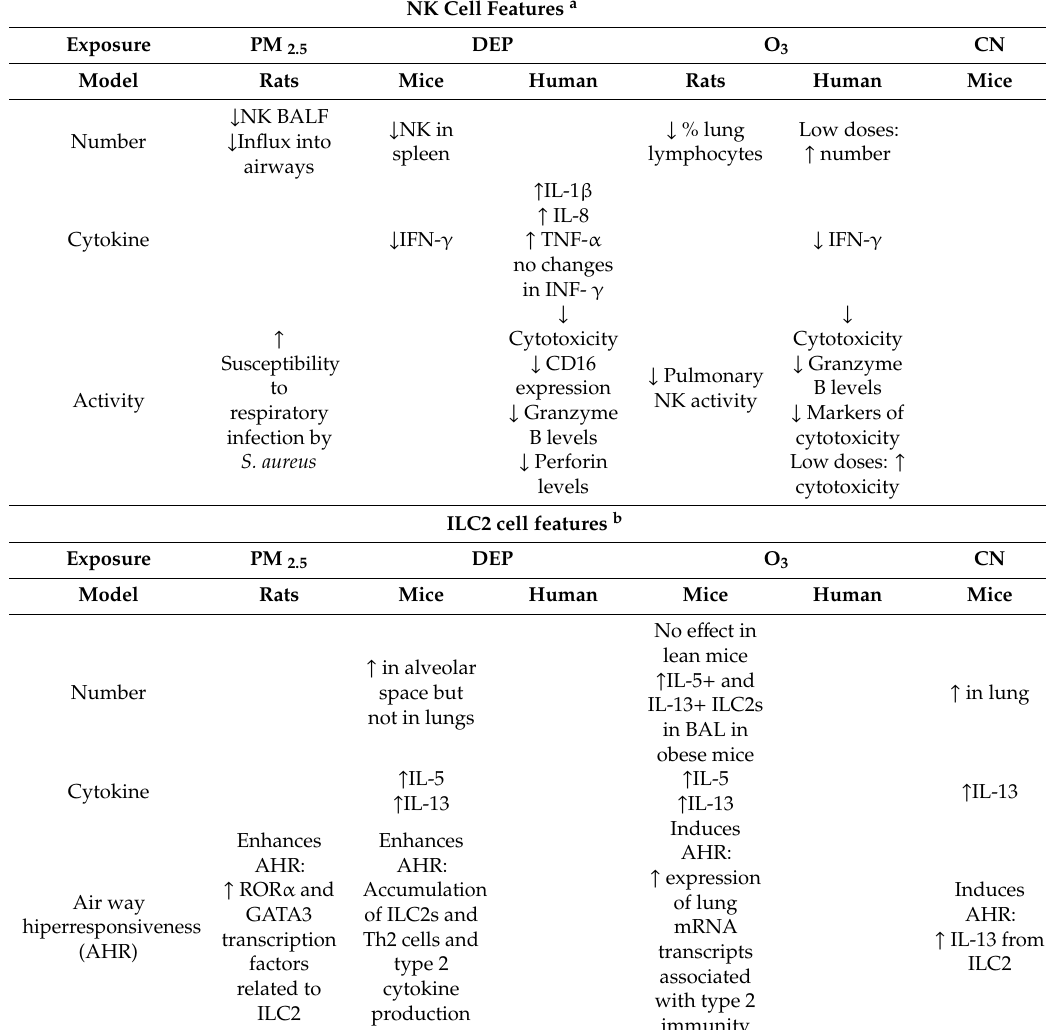
Table 2. E ff ects of air pollutants on NK cells and ILC2: integration of